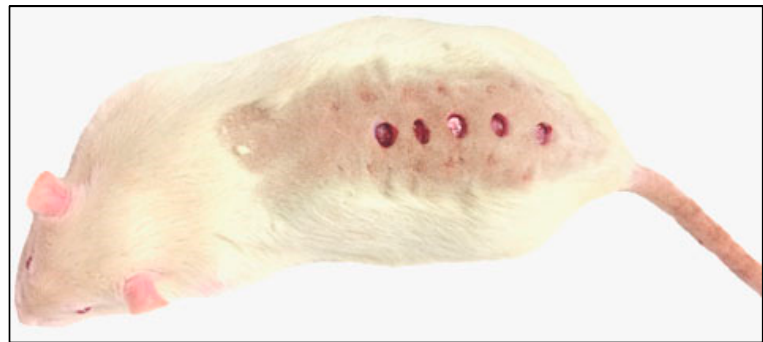
Figure 13. Localization of individual excisions on rat dorsum.